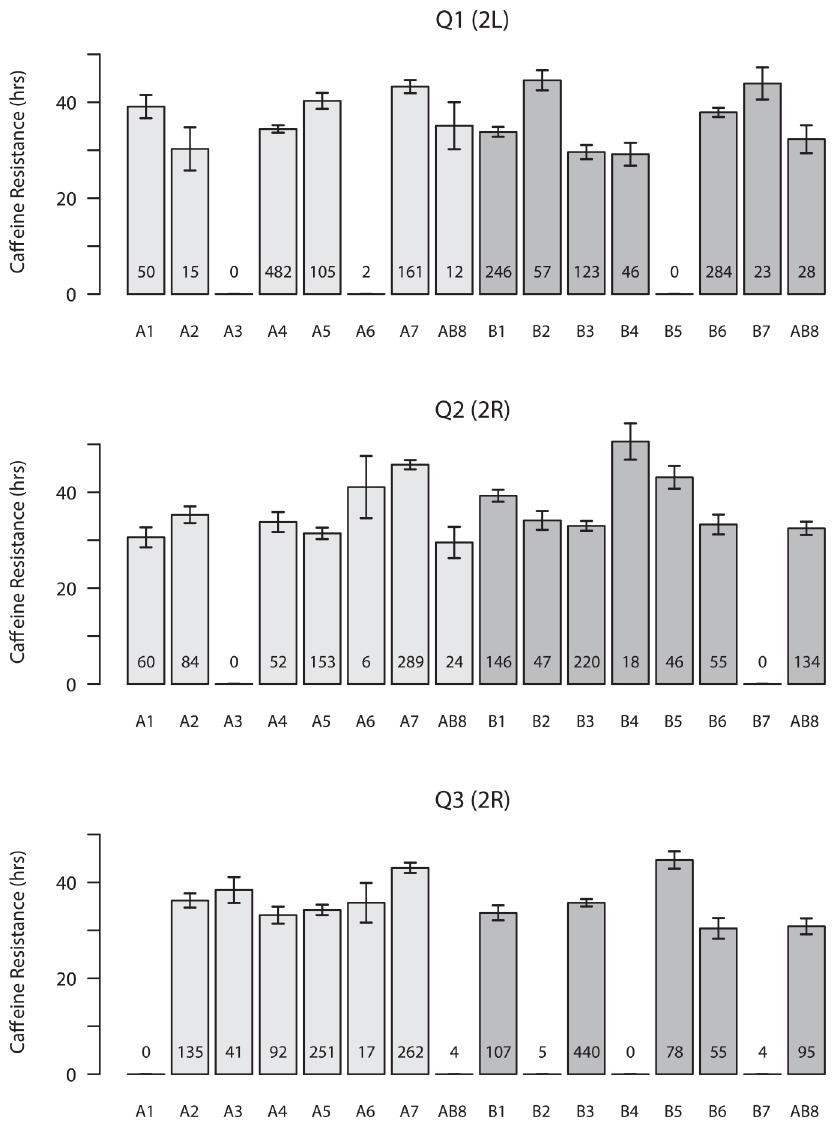
Fig 2. Founder haplotype means and 1-SDs for the three QTL mapped in both panels of DSPR RILs. Means are presented for both pA (light gray bars) and pB (dark gray bars), and the number of RILs for which we assign a founder genotype (probability > 0.95) is listed at the bottom of each bar. Only founder means associated with at least 5 observations are presented. Since line AB8 was used to found both synthetic populations, and the haplotype mean was independently estimated from pA and pB RILs, the line is presented twice in each